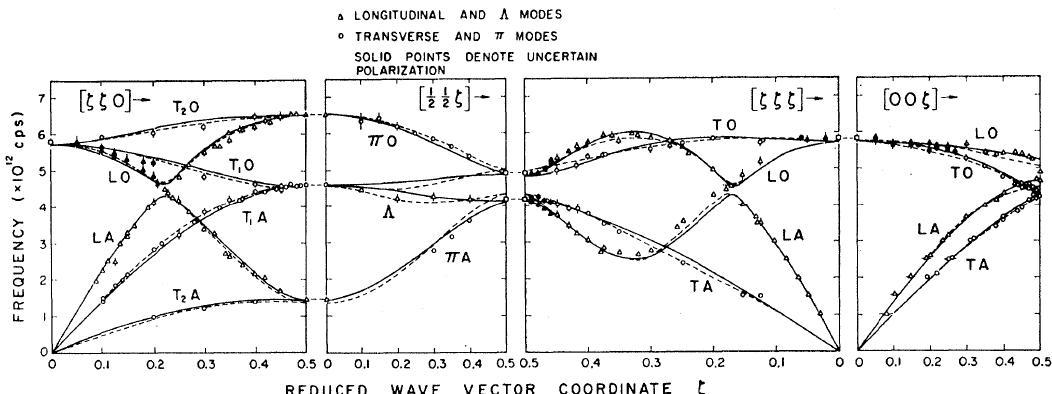
Figure 33. The phonon dispersion relations in β -brass at 296 K for high-symmetry directions. Triangular points denote L and Λ modes and circles denote T and Π modes. Solid points denote uncertain polarization. The solid curve represents the fit to a Born–von Kármán model to fourth nearest neighbors. The dashed curve is the fit obtained with an oscillatory pseudopotential model. This figure is taken from Figure 2 of ref. [87]. Copyright by the American Physical Society.